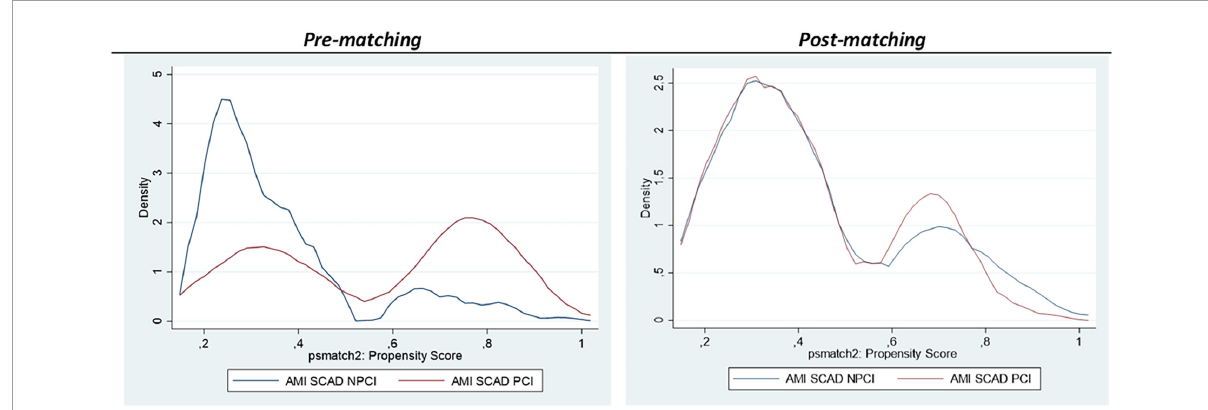
FIGURE2 Kernel Density plots representing the pre and post matching. In-hospital